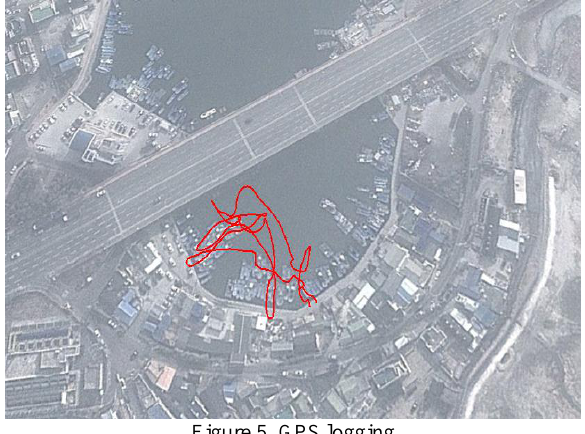
Figure 5. GPS logging